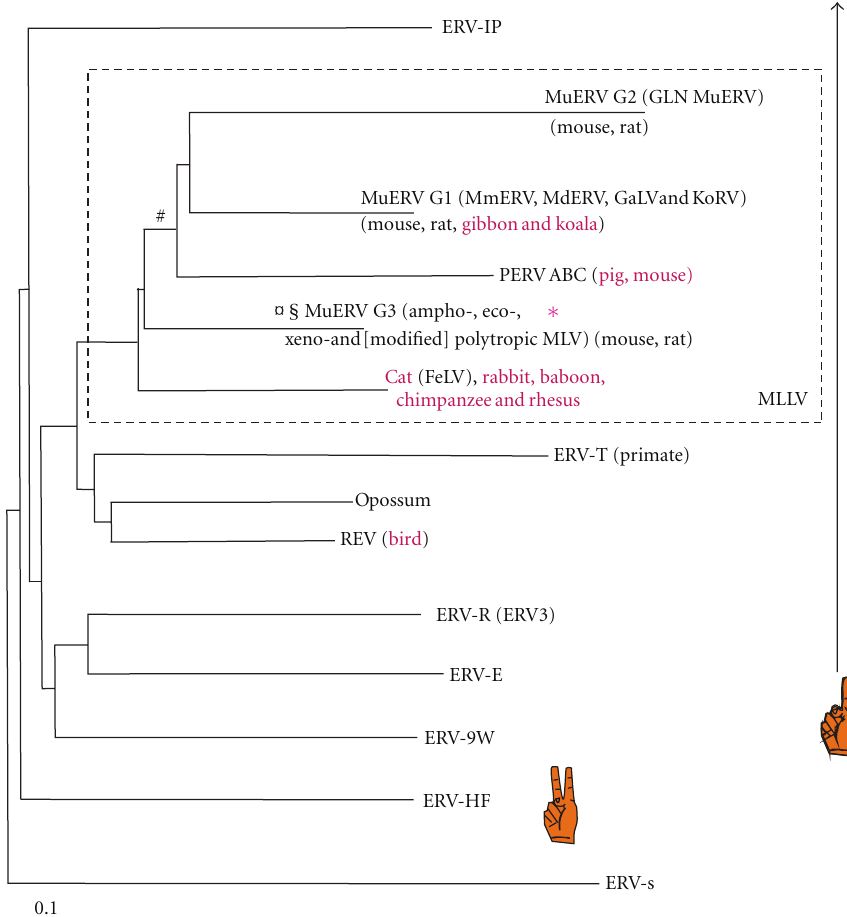
Figure 1: Simplified phylogeny of gammaretroviruses based on over 2000 gammaretrovirus-like sequences with one zinc finger in Gag, from selected vertebrate genomes (in a first version of RetroBank) and reference gammaretroviruses. Retroviral groups which occur in phylogenetically distant vertebrate hosts, indicating cross-species transmission events, are shown in red. The neighbor-joining tree was based on an alignment of 105 reference and consensus Pol amino acid sequences. Only the major branches are shown. As explained in the text, they were provisionally named after the cosegregating HERV group. The group of “MLV-like viruses,” MLLVs, at least 60% similar in Pol, is boxed in. The similarity is calculated from the inverted ratio of the BLASTP score of the sequence against itself to another sequence, or to a consensus Pol sequence. Some two-zinc finger sequences (ERV-HF, containing HERV-H and HERV-F) were included as a reference. Although the clustering included several genomes, the groups were named from the human sequence representative. MuERV: mouse endogenous retrovirus. MmERV is from Bromham et al. [13], and MdERV is Mus dunni ERV from Wolgamot et al. [14]. GLN MuERV is from Ribet et al. [15]. Symbols: ∗ position of XMRV/HMRV, § recombinant MuERV Sp496-5Sb [16] from Mus spretus, hortulanus endogenous murine virus, HEMV, from Mus spicilegus [17], # MuRRS [18], and MuERVC [19]. An ERV-S sequence [20] was used to root the tree. It came from HERV-S, a sequence intermediate to spuma-, epsilon-, and gammaretroviruses. It belongs to the so-called “ERV3 family” according to the RepBase nomenclature [21]. This large clade is also called “Class III ERVs.” It should not be confused with the ERV3 group shown in the figure. The hand symbols denote proviruses with one and two zinc fingers in Gag, respectively. The murine gammaretroviral groups G1-G3 are described in greater detail in a forthcoming paper (Elfaitouri et al., accepted, Plos One).